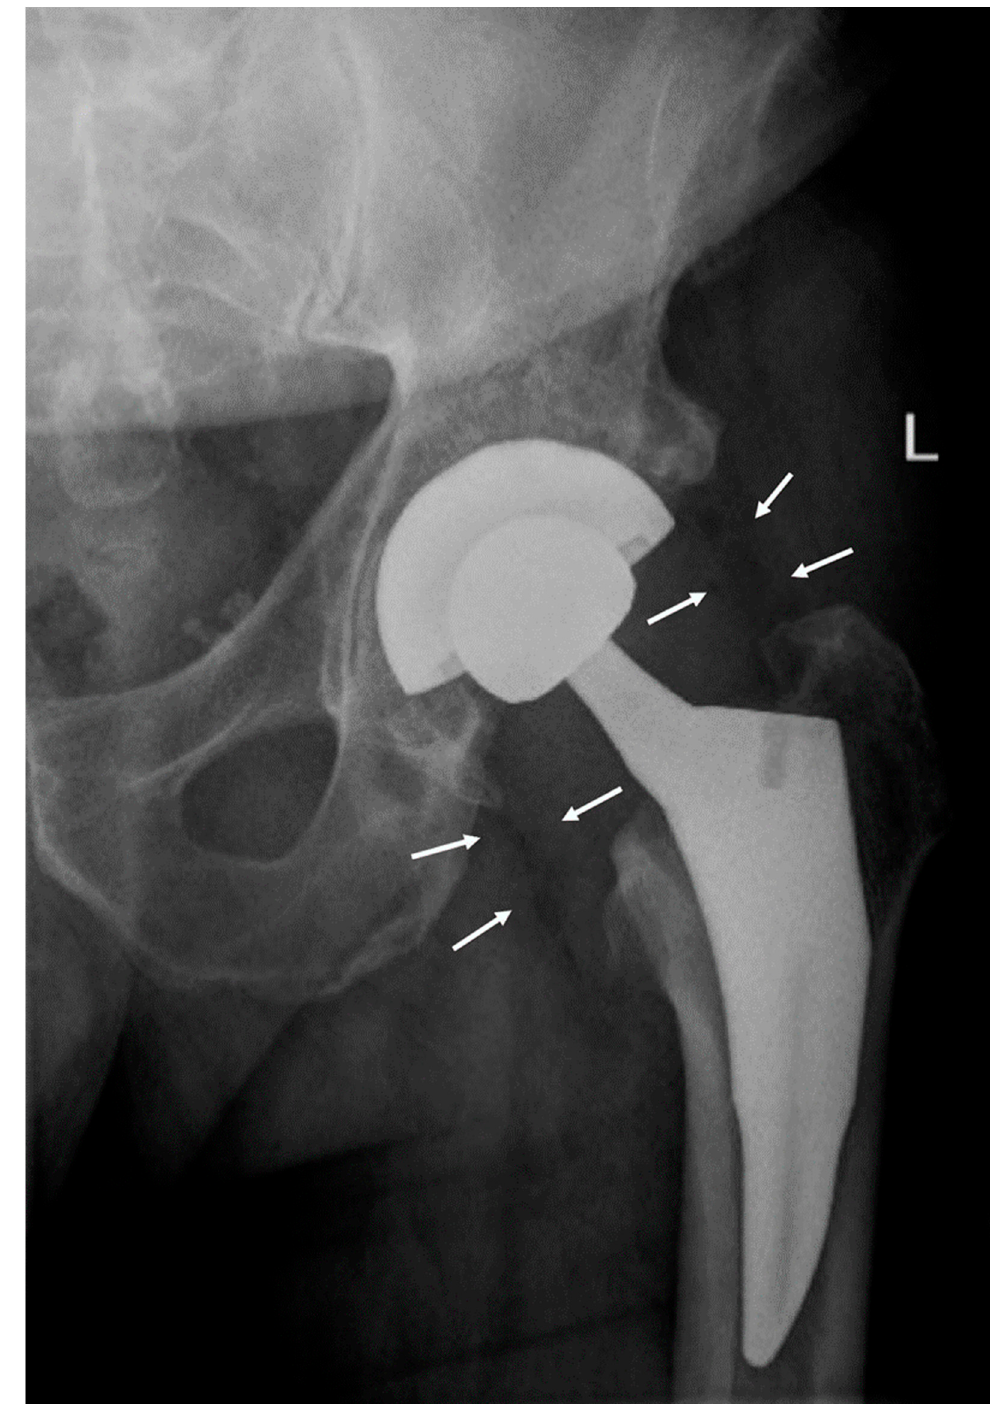
Figure 1. A hip radiograph demonstrating periprosthetic gas in soft tissue. Two foci of gas are outlined by white arrows; the largest focus of gas is at the lateral aspect of the hip. The patient underwent a total left hip replacement eight days prior to the onset of tetanus symptoms and demonstrated no other evidence of deep or superficial injury.